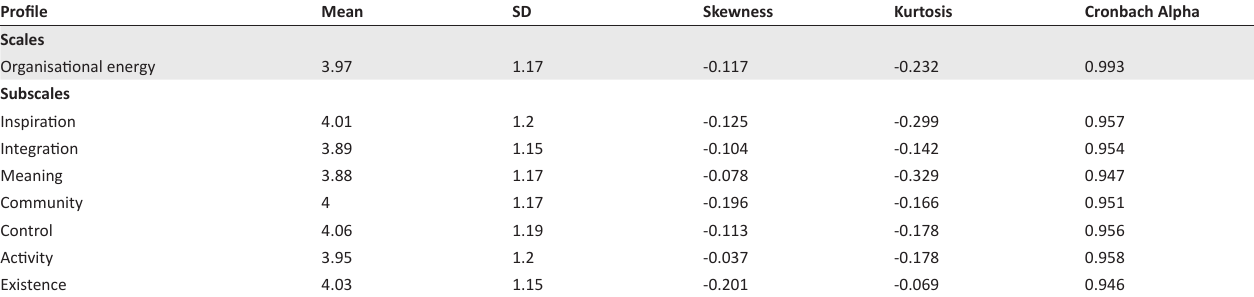
TABLE 2: Descriptive statistics and Alpha coefficients – EnergyScapes Profile.